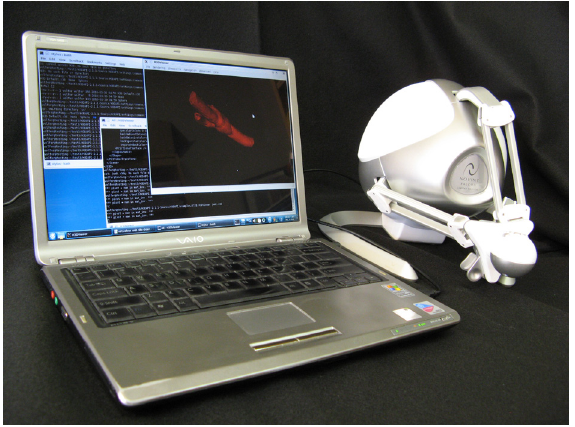
Figure 11. Haptic Aorta Exploration